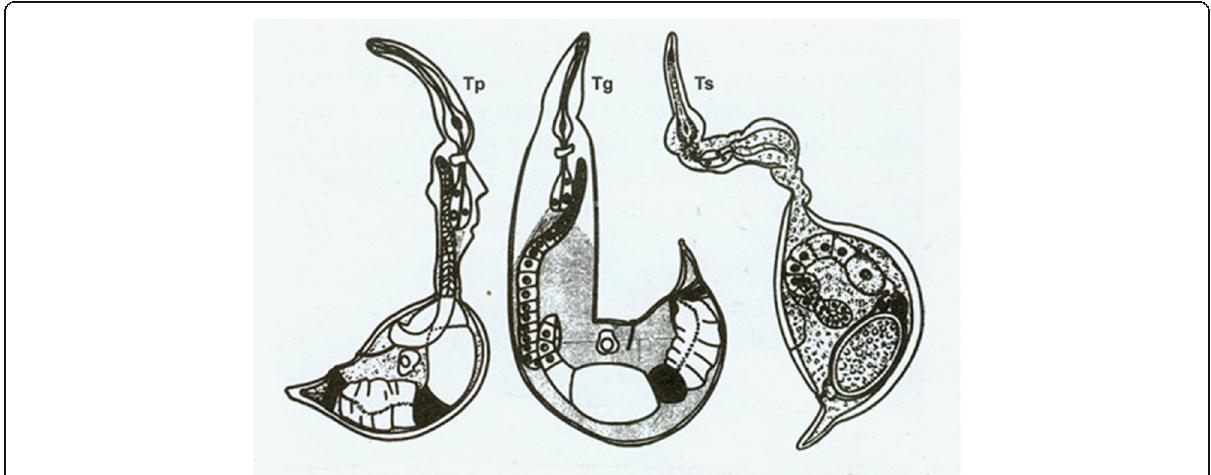
Fig. 2 Drawings of mature females. Tylenchulus palustris (Tp), T . graminis (Tg), and T . semipenetrans (Ts). Tylenchulus graminis and T . palustris parasitize native plants of Florida, whereas T . semipenetrans is a citrus parasitic species (Inserra et al.